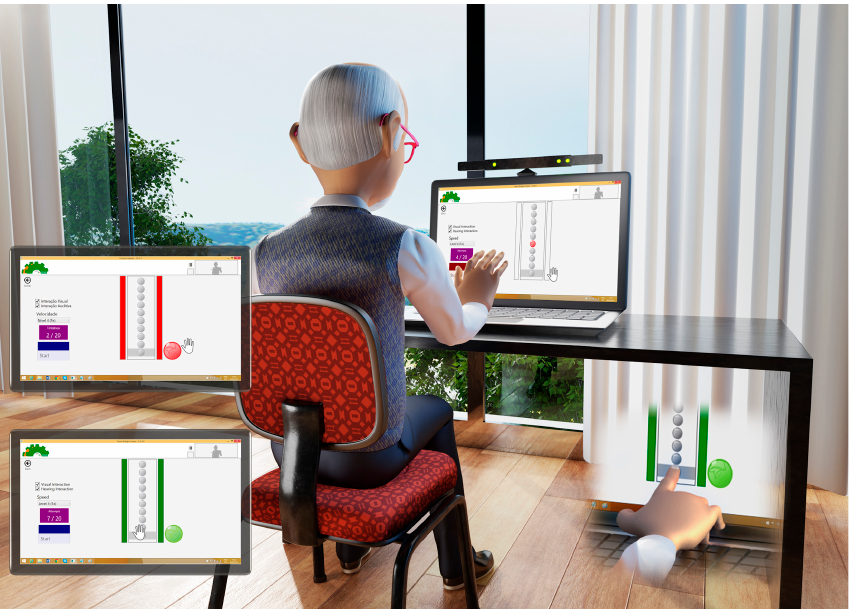
Figure 1. Task execution using virtual interface (Kinect—top right) and real interface (touch screen—bottom right). On the left is the demonstration of the feedback—Hit (green light—bottom left) and Miss (red light—top left).